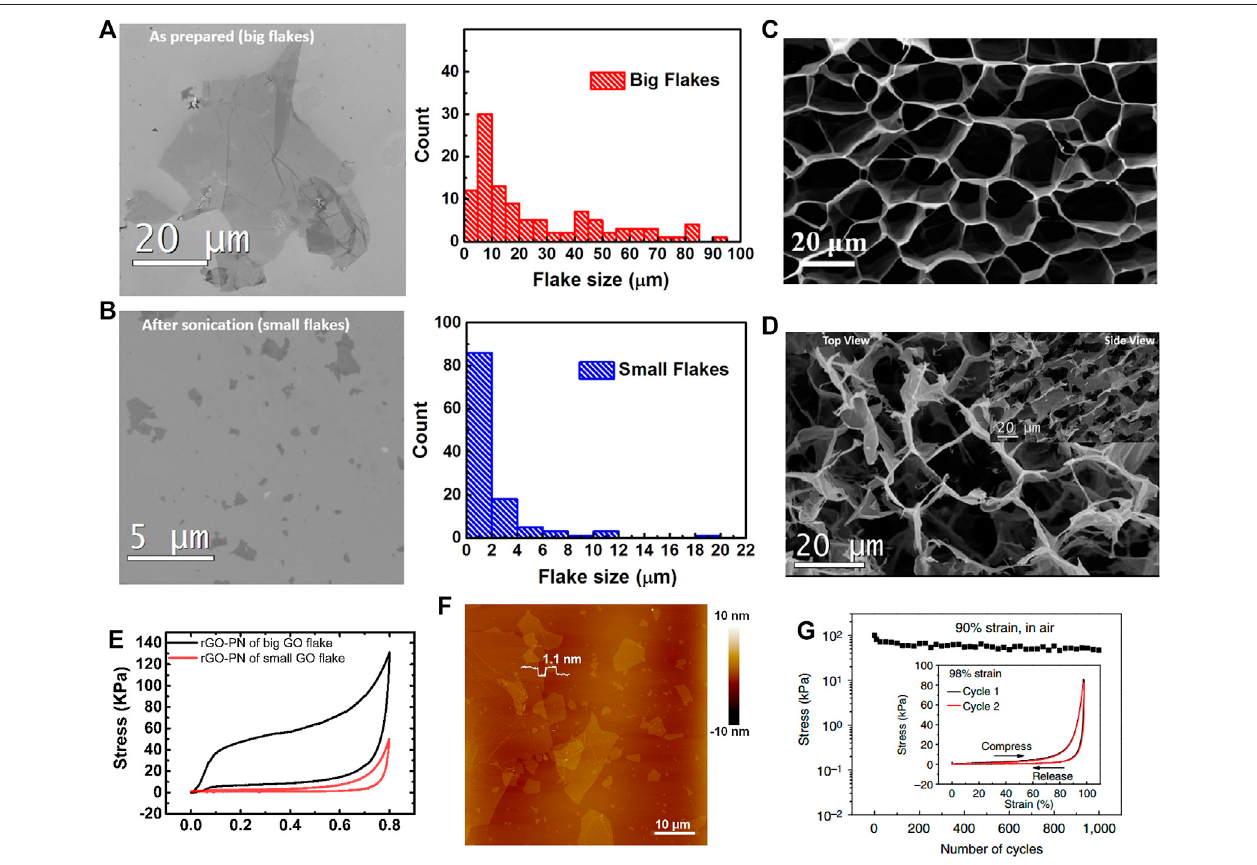
FIGURE 3 | SEM images and size distributions of large (A) and small (B) GO sheets (Ni et al., 2015). SEM images of 3GAs prepared by large (C) and small (D) GO sheets (Ni et al., 2015). (E) Compressive stress – strain curves of 3GAs prepared by large and small GO sheets (Ni et al., 2015). (F) AFM image of GO sheets with a large size of 20 – 50 μ m (Wu et al., 2015). (G) Compressive stress – strain curves of 3GA for 1,000 cycles in air. Inset: Compressive stress – strain curves of 3GA for two cycles under the compressive strain of 98% (Wu et al.,